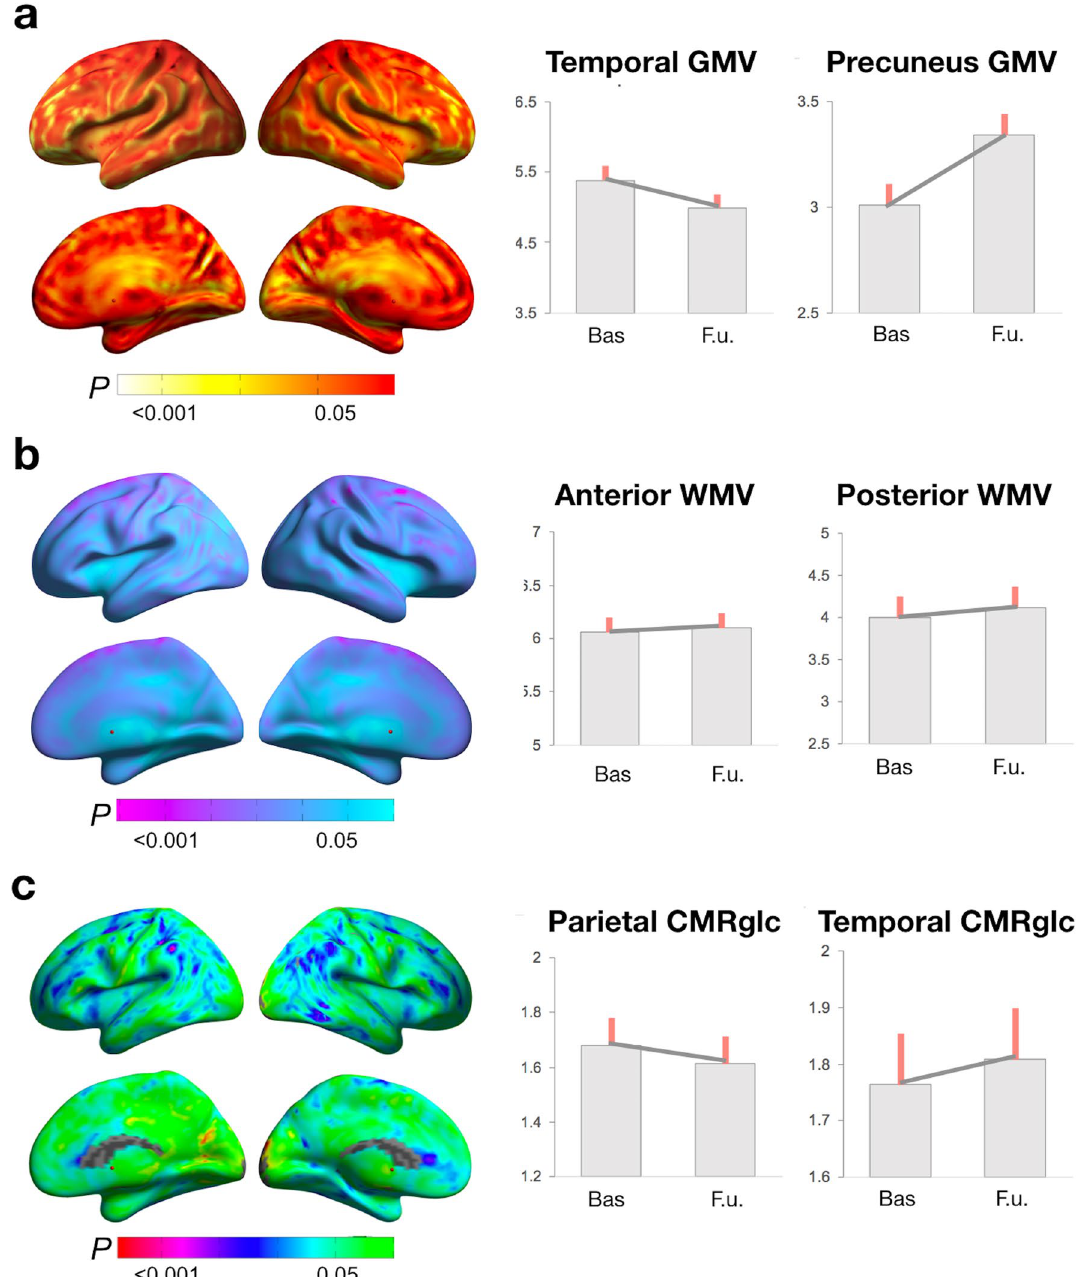
Figure 4. Longitudinal biomarker changes post-menopause. ( a) Surface maps of GMV change. ( b ) Surface maps of WMV change. ( c ) Surface maps of CMRglc change. ( d ) Plots representing mean (SE) biomarker levels at baseline (POST) versus 2-year follow-up (POST + 2) in the subset of POST participants with longitudinal brain scans. Surface maps are represented on modality-specific color-coded scales with corresponding p values. See legends to Figs. 1 and